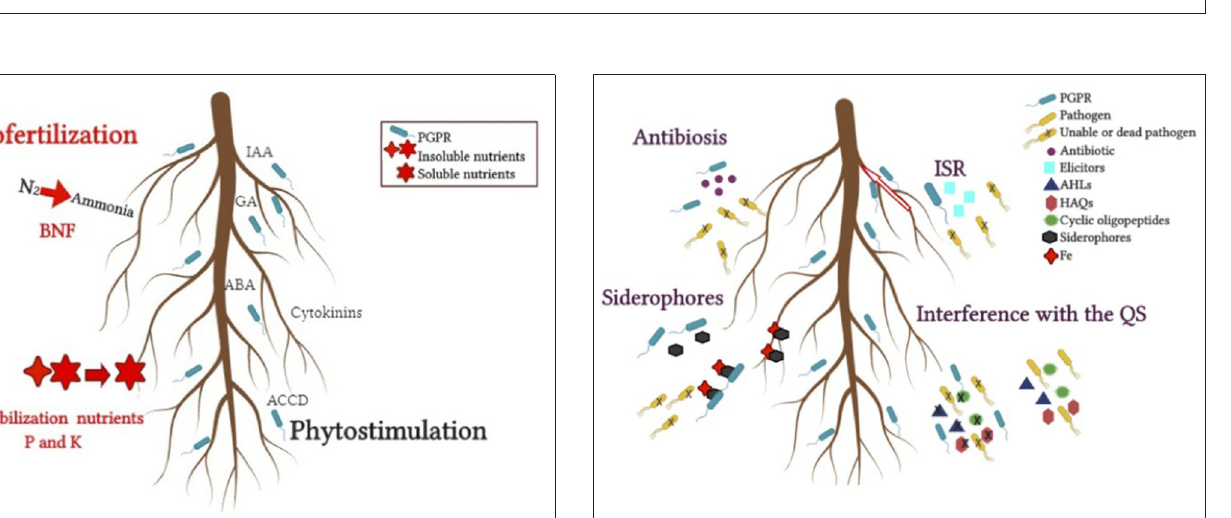
FIGURE 3 | Indirect mechanisms that benefit plant growth from host-PGPR interactions. Antibiosis, siderophores, interference with the quorum sensing (QS), induced systemic resistance